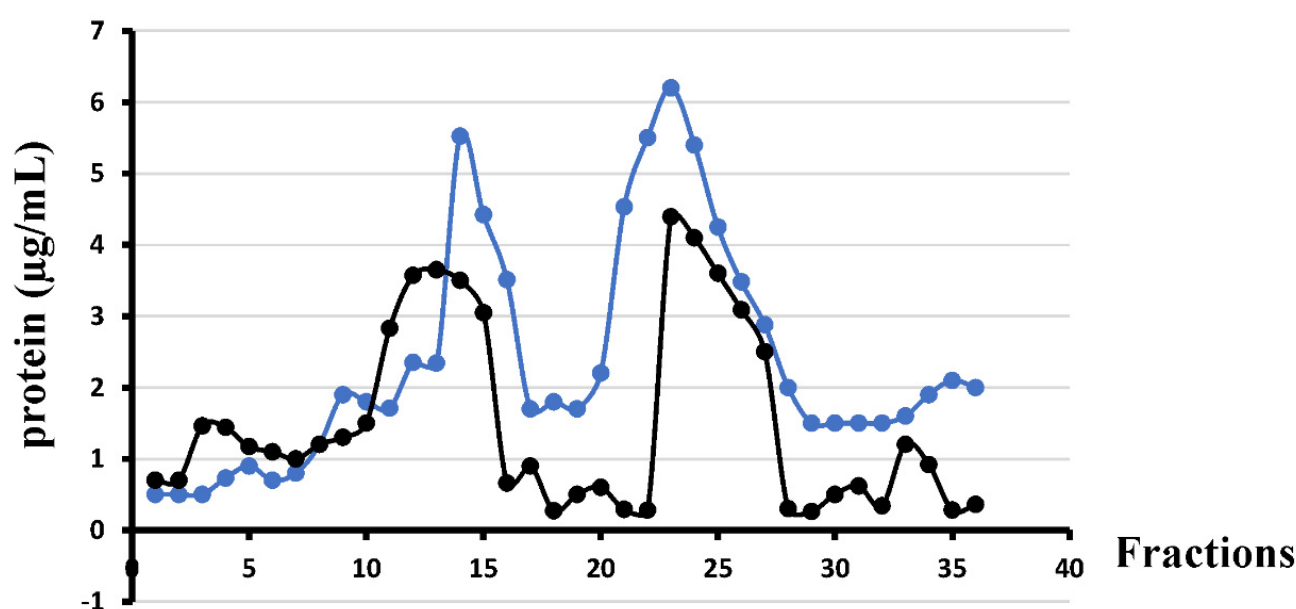
Figure 1. Separation of the L. gormanii inner (IM) and outer membrane (OM) by sucrose density gradient centrifugation. The 1 mL fractions were collected from the top of the gradient and assayed for the presence of protein ( µ g/mL). Black line: bacteria cultured on the exogenous choline non-supplemented medium; blue line: bacteria cultured on the exogenous choline-supplemented medium.